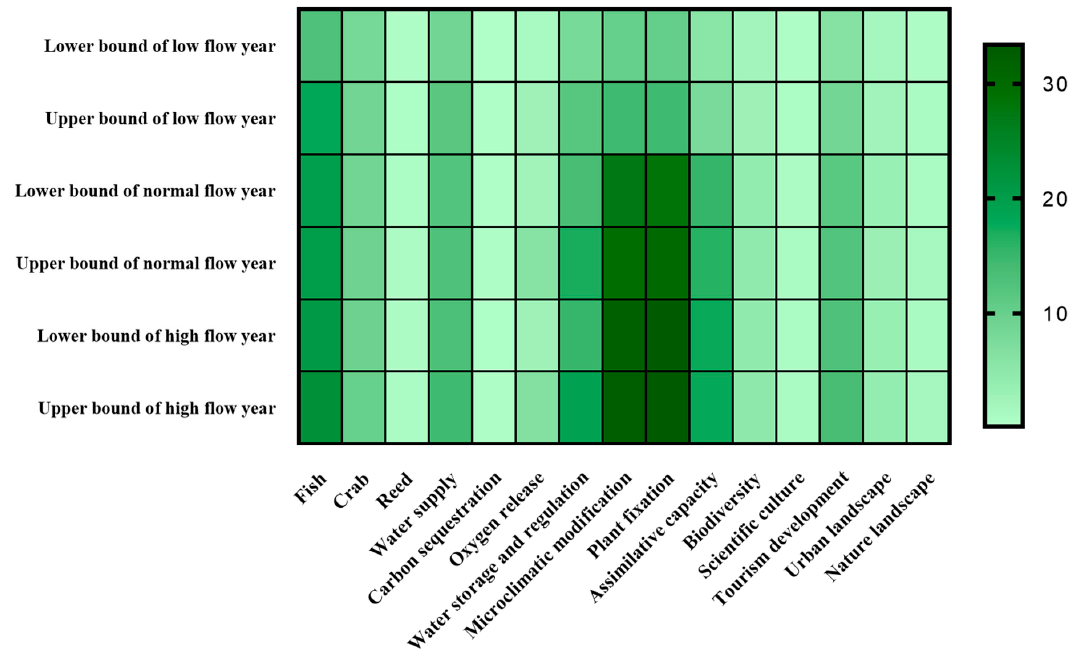
Figure 5. The comparison of different ecological services.